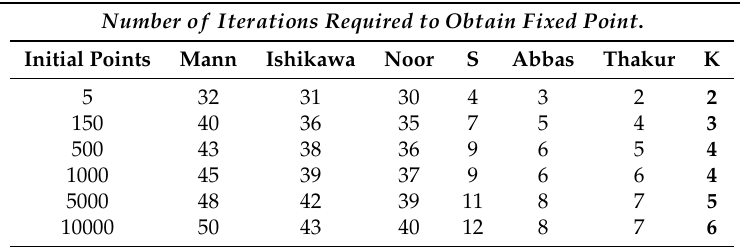
Table 1. Influence of initial points for various iterative algorithms. Number of Iterations Required to Obtain Fixed Point .